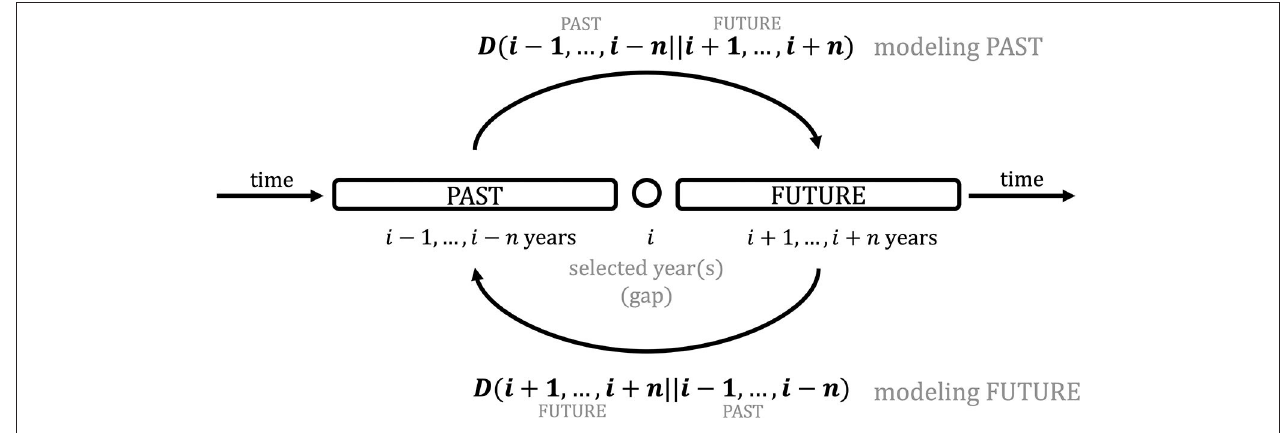
FIGURE 1 | Data-driven periodization with Kullback-Leibler